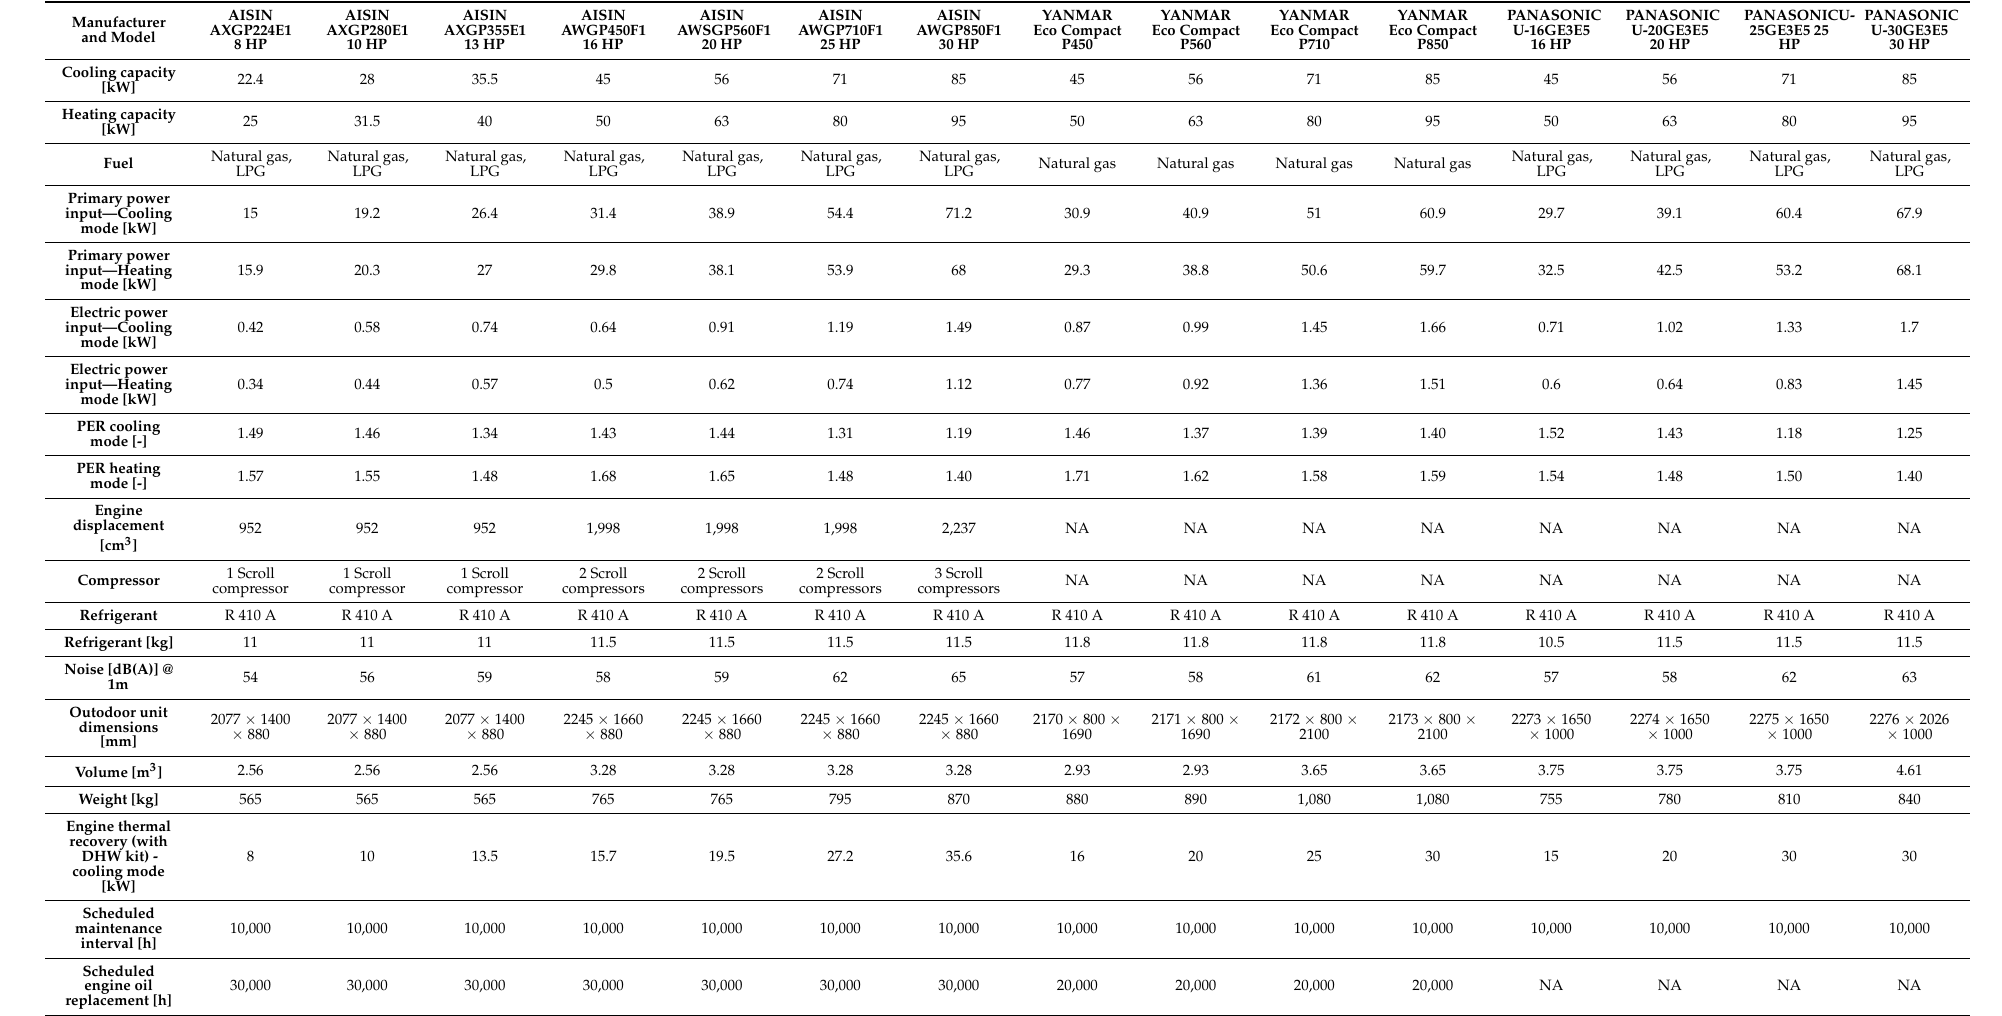
Table A2. Air-to-air GEHPs (cooling: A35/A27, heating: A7/A20) available on the European